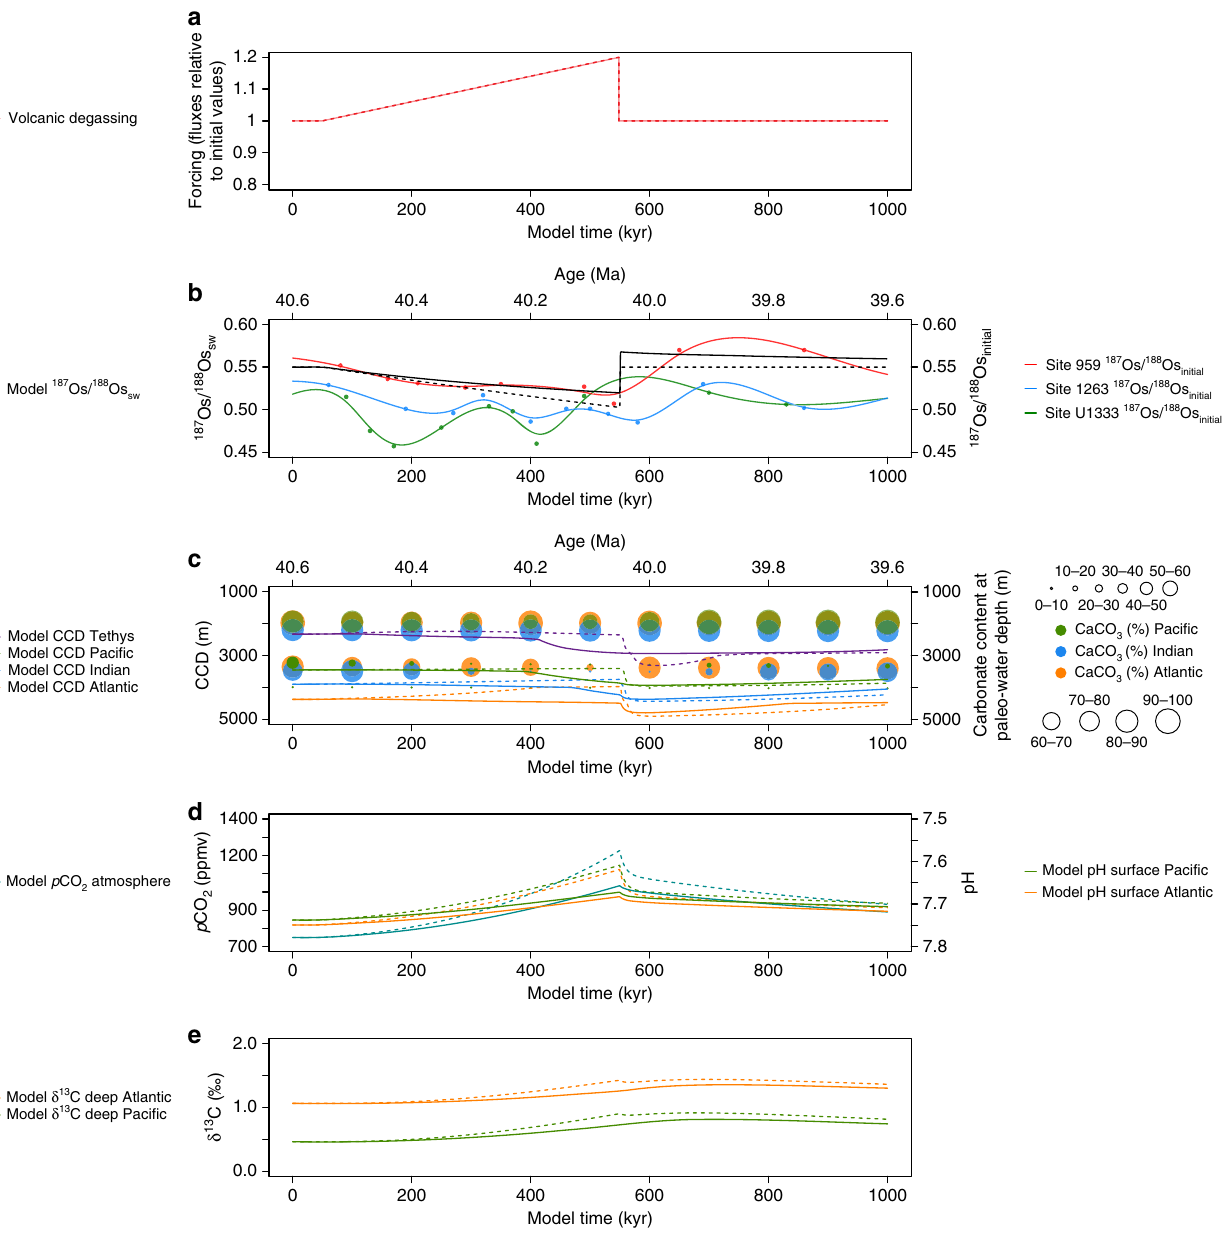
Fig. 3 LOSCAR and Os cycle model simulations of the most likely MECO scenario. a Forcing for two scenarios involving a gradual, transient 20% increase in the volcanic CO 2 fl ux over ~500 kyr. The solid lines represent a scenario in which the silicate and carbonate weathering fl uxes are allowed to vary in response to CO 2 forcing (normal weathering feedback), while the dashed lines represent a scenario in which these weathering fl uxes are kept constant (diminished weathering feedback). Only the latter scenario corresponds to all observations. b Model response in the 187 Os/ 188 Os composition of the global ocean, shown against smoothed fi ts to the MECO Os i records from the study sites. c Model CCD response of different ocean basins, shown against carbonate content (wt%) records for different depths in the Atlantic, Indian and Paci fi c oceans as compiled by Sluijs et al 8 . d Model atmospheric p CO 2 response and pH response for the surface Atlantic and Paci fi c oceans. e Model δ 13 C response for the DIC of the deep Atlantic and Paci fi c oceans. For a full description of the LOSCAR model, see Zeebe